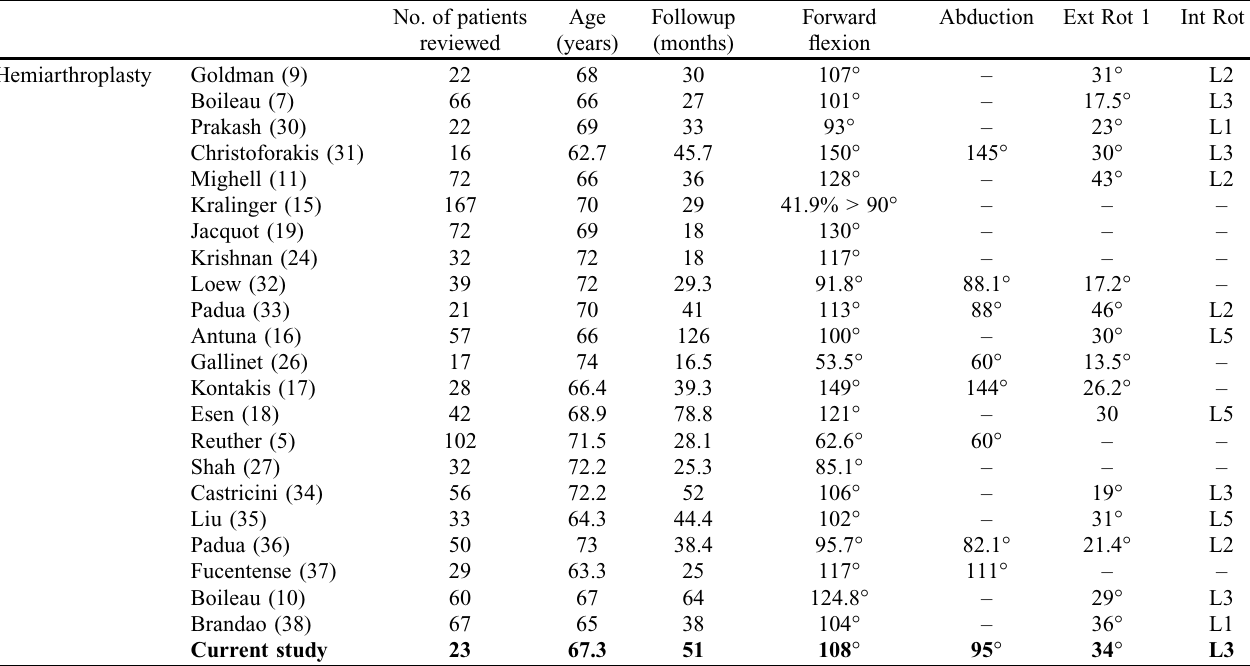
Table 2. Joint range of motion reported in published studies of hemiarthroplasty for proximal humerus